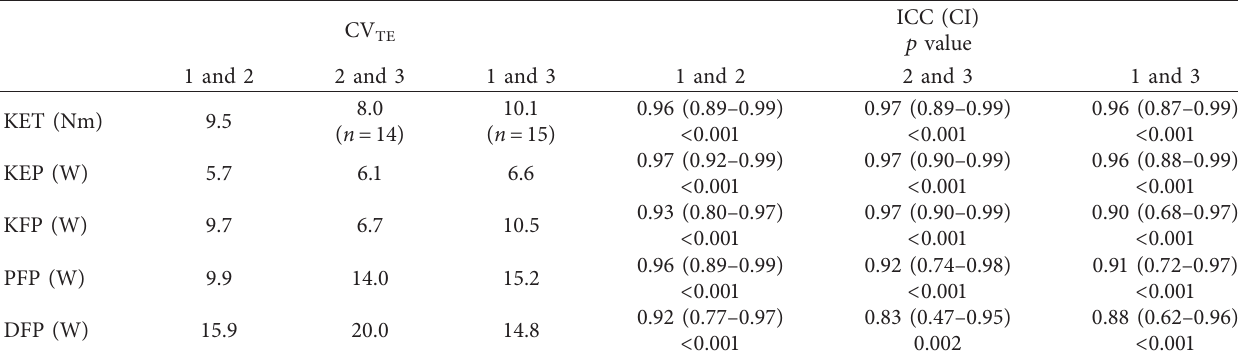
Table 5: Reliability data for muscle torque (Nm) and muscle power (W) for time points 1 and 2 (weeks 0–9; n � 17), 2 and 3 (weeks 9–15; n � 13), and 1 and 3 (weeks 0–15; n � 14).